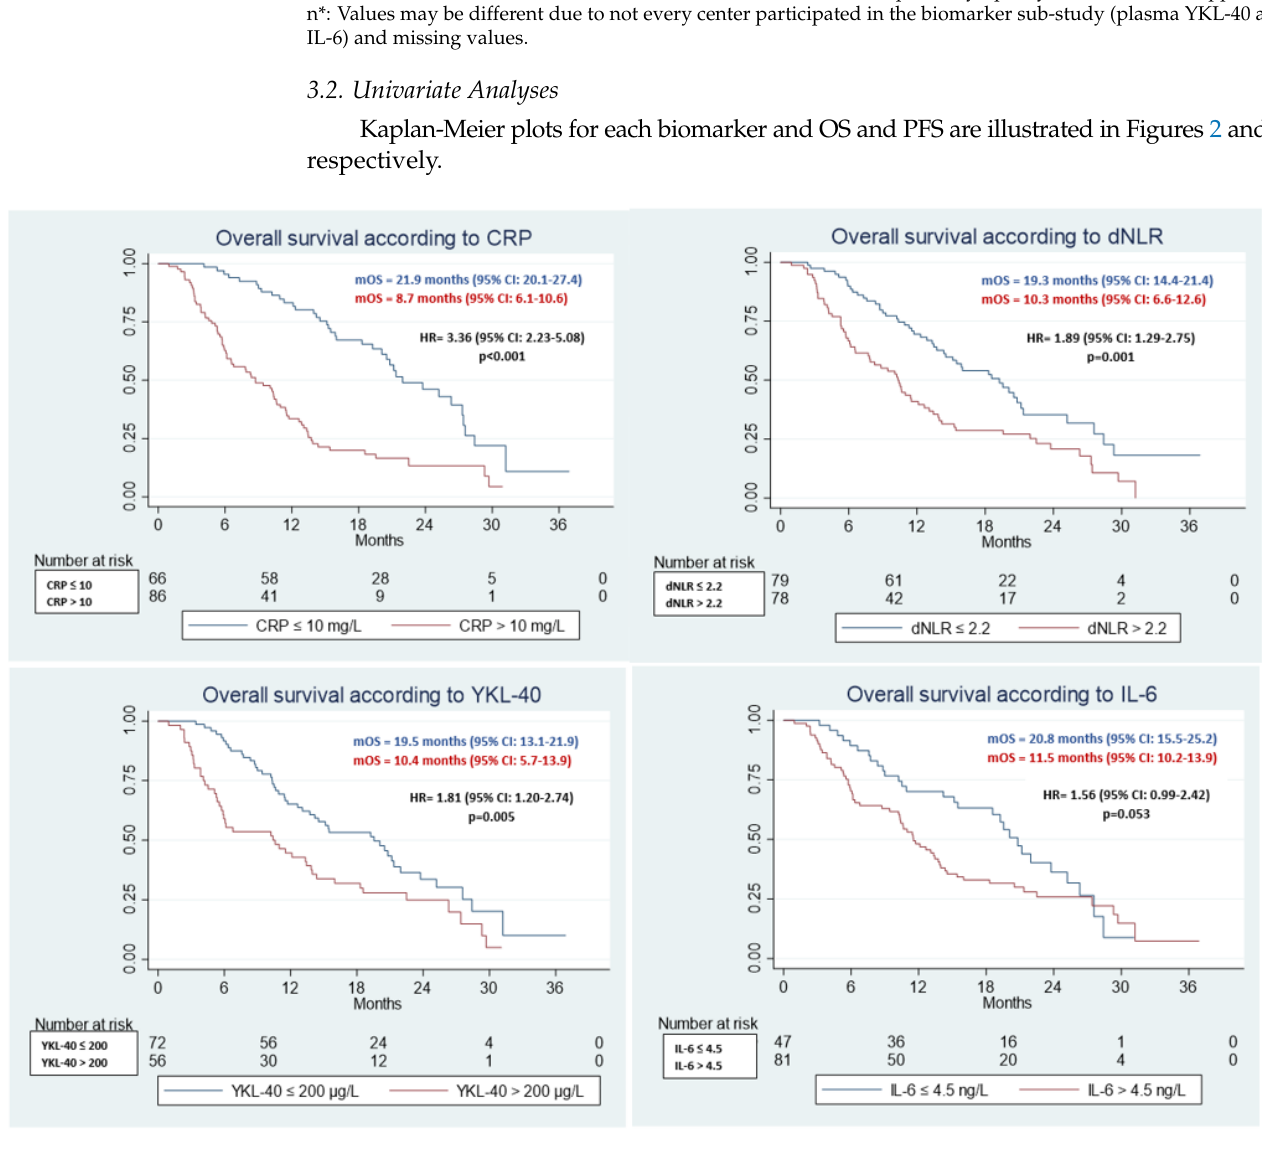
Figure 2. Kaplan-Meier plots showing baseline dichotomized biomarker (normal/high) associations with overall survival.